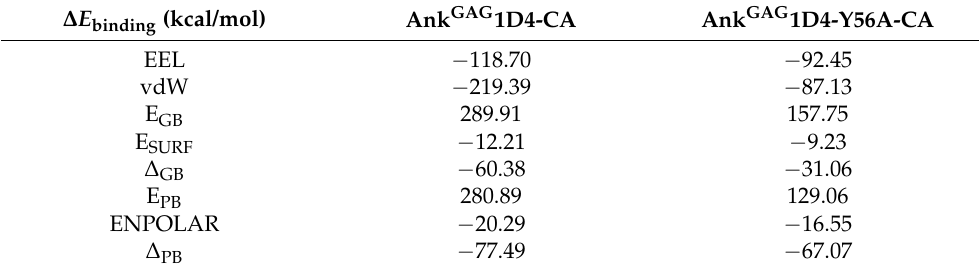
Table 1. Binding affinity derived from MMGBSA and MMPBSA for Ank GAG 1D4-CA and Ank GAG 1D4- Y56A-CA complexes. EEL, MM electrostatic energy; vdW, van der Waals energy while the polar and non-polar term for MMGBSA/MMPBSA are EGB/EPB and ESURF/ENPOLAR, respectively. ∆ E binding